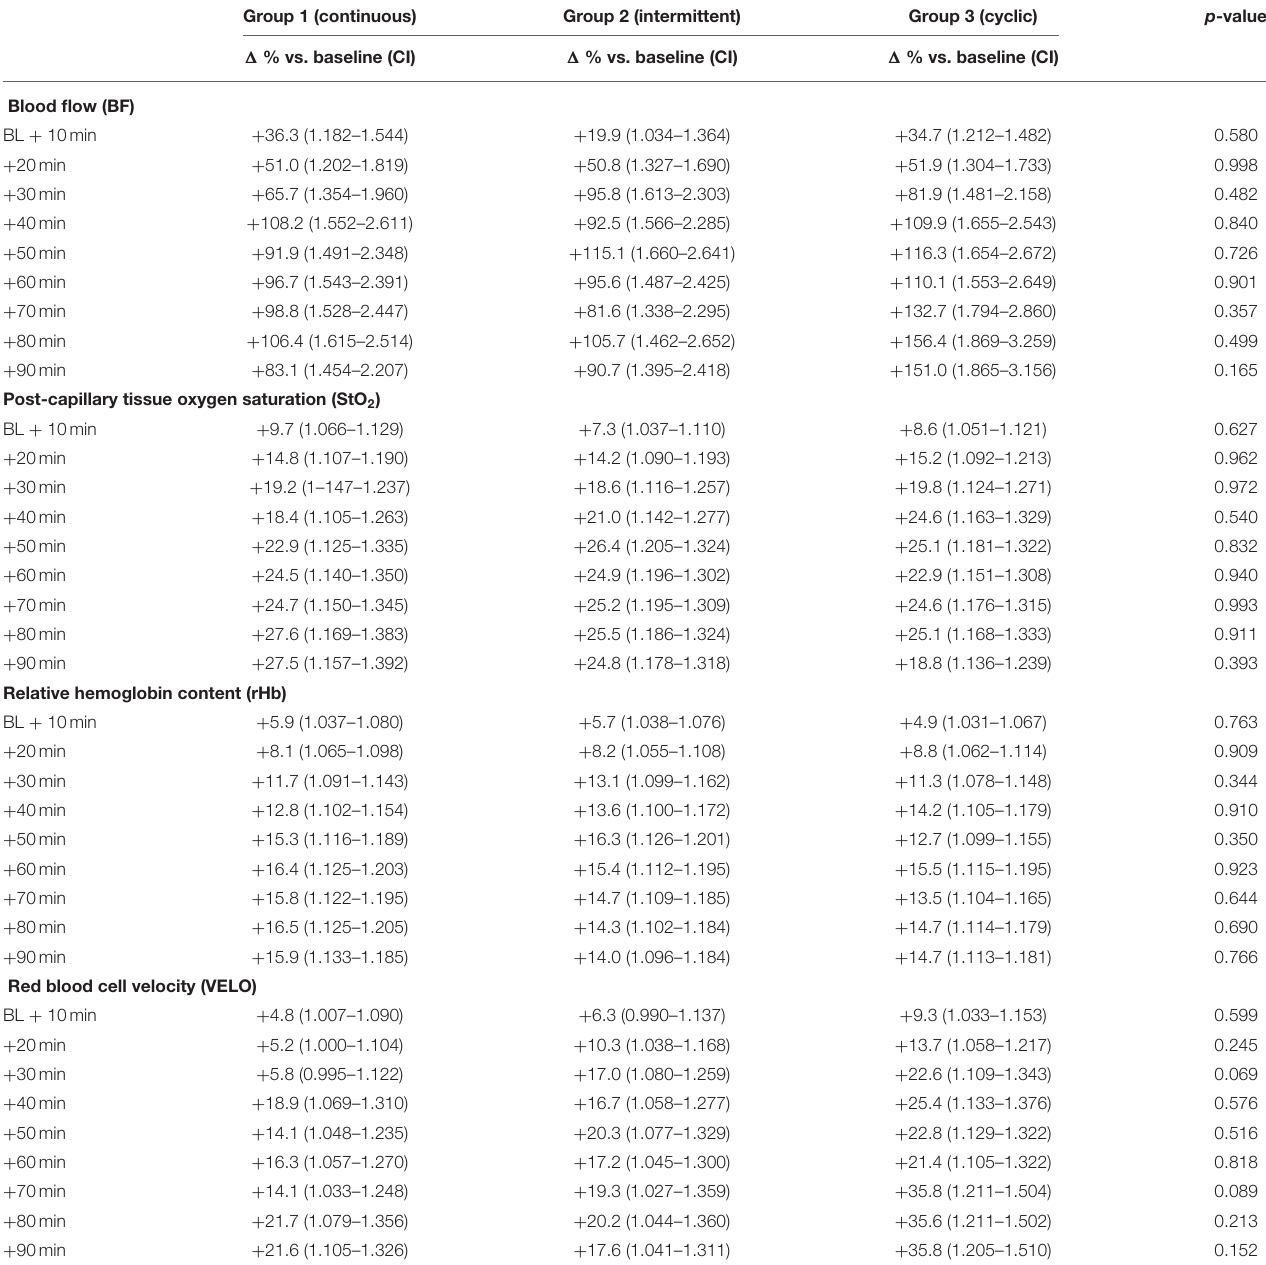
TABLE 2 | Microcirculatory data (Negative Pressure Wound Therapy, NPWT). Group 1 (continuous) Group 2 (intermittent) Group 3 (cyclic) p